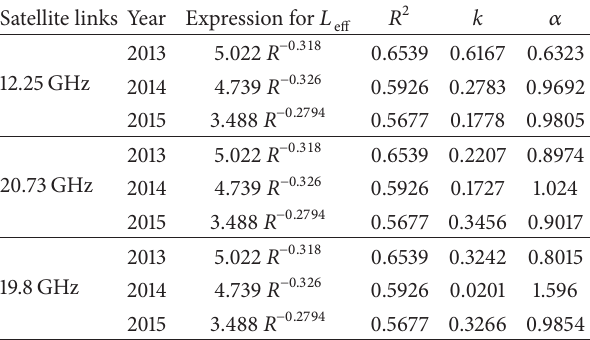
Table 4: Regression coefficients for three satellite links [20]. Satellite links Year Expression for 𝐿 eff 𝑅 2 k 𝛼